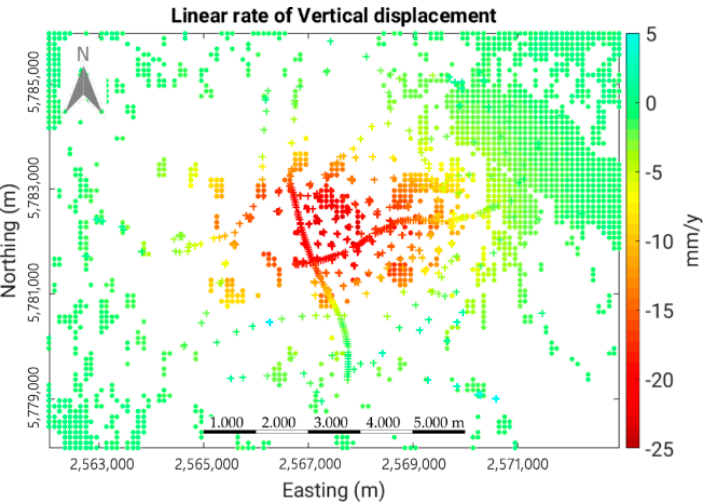
Figure 12. Linear displacement rate transformed to vertical with Multi-Mogi approach (bullets) together with linear rates from levelling (crosses).